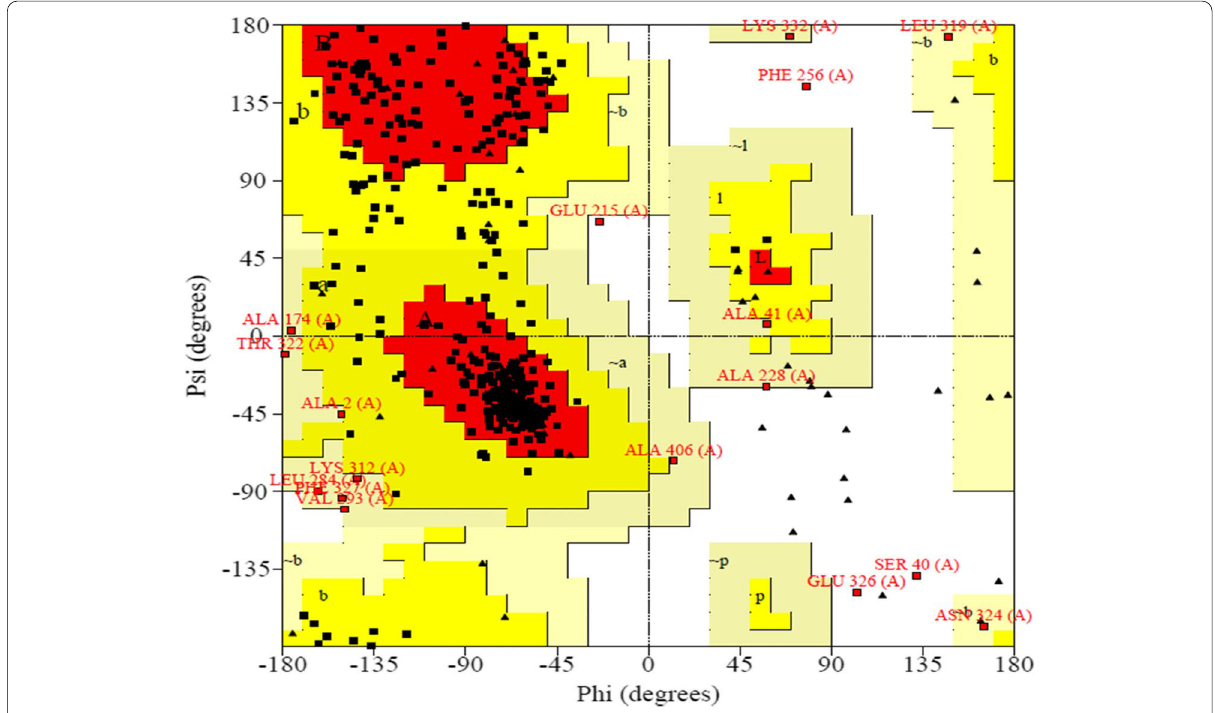
Fig. 4 Ramachandran plot, PROCHECK tool generated a 3D model of the vaccine construct